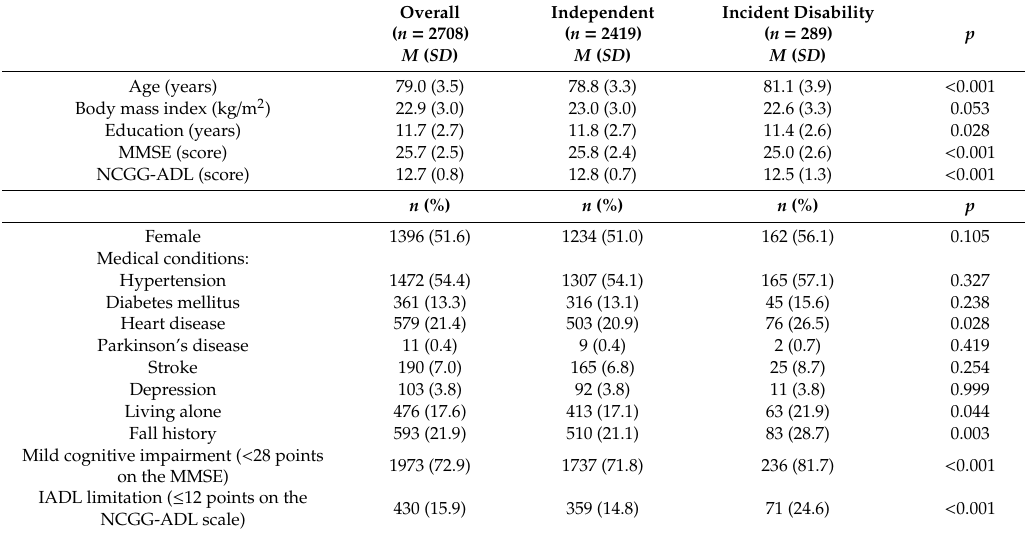
Table 1. Baseline characteristics of participants ( N =